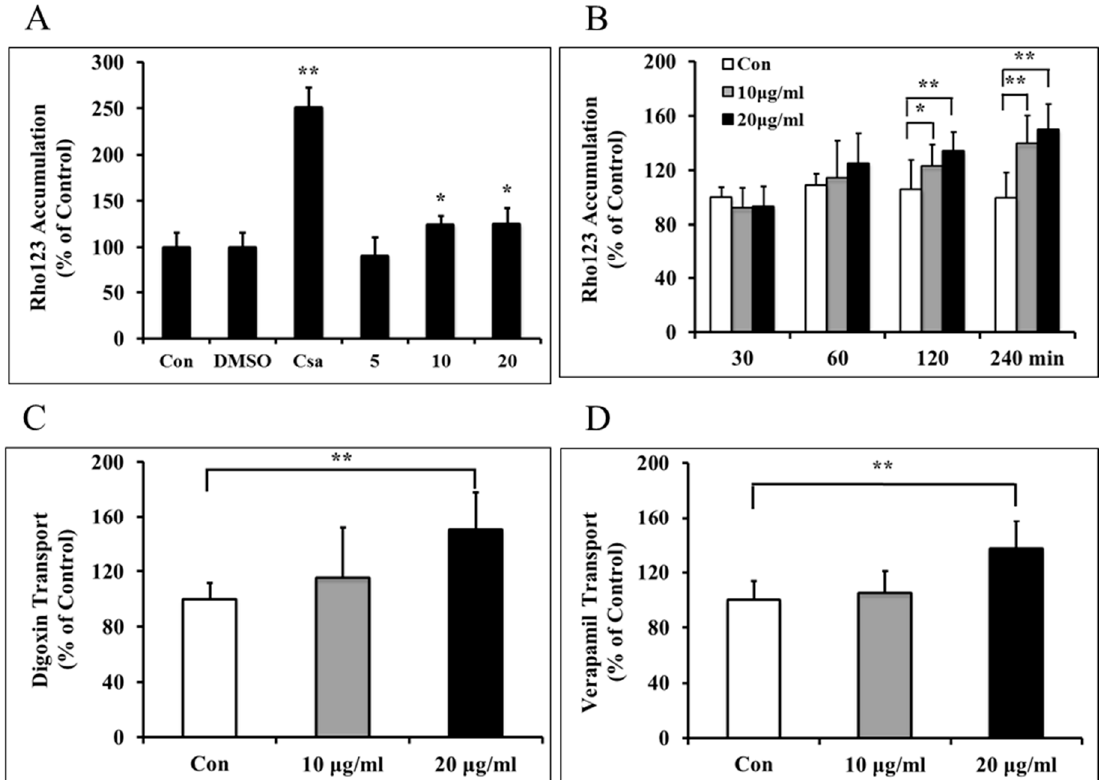
Figure 3. Effects of borneol on P-gp-mediated efflux function in BMECs. ( A ) Borneol increased the BMECs uptake of the P-gp substrate Rho123 in a dose-dependent manner. Con, control; DMSO, dimethyl sulphoxide; Csa, cyclosporin A; ( B ) Borneol increased cellular accumulation of Rho123 in a time-dependent manner; ( C ) Borneol enhanced P-gp substrate digoxin transport across the BBB in vitro model analyzed by high performance liquid chromatography (HPLC) at 4 h after treatment; ( D ) Borneol enhanced P-gp substrate verapamil transport across the BBB in vitro model analyzed by HPLC at 4 h after treatment. Data are expressed as mean + SD; * p < 0.05, ** p < 0.01 ( n = 8 per group).